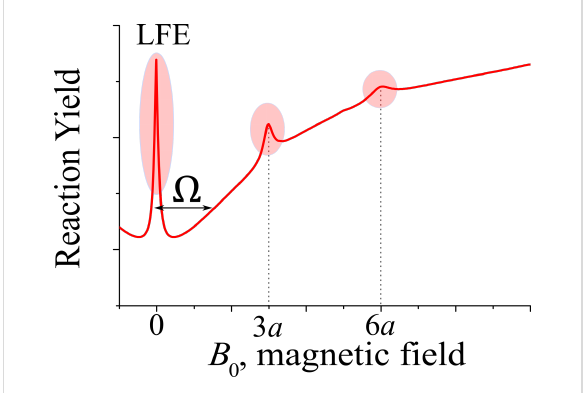
Figure 8: MARY curve, i.e., magnetic field dependence of the reaction yield for a singlet-born radical pair. Here sharp maxima correspond to crossings of the spin energy levels of the radical pair. A crossing at zero field gives rise to the low-field effect (LFE). Additional level cross- ings are found at specific field strengths (e.g., for radical with 6 equiva- lent magnetic nuclei these fields are 3 a and 6 a ). The width, Ω (given by the effective HFC of the radical pair), of the broad MARY line at B 0 = 0 is also